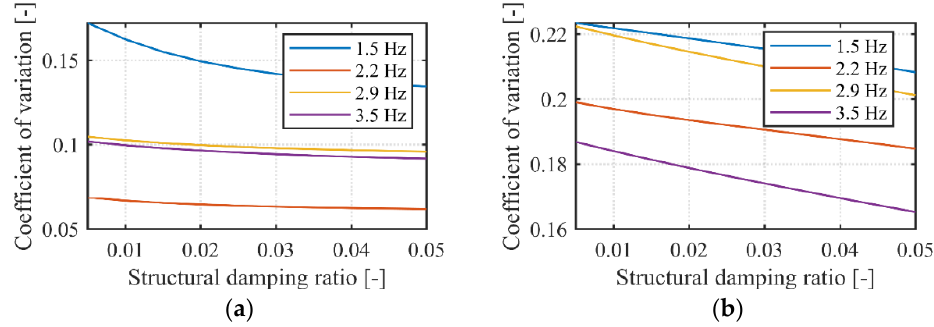
Figure 11. Relationship between coefficient of variation and crowd size. ( a ) Relationship for the first harmonic, ( b ) Relationship for the second harmonic.